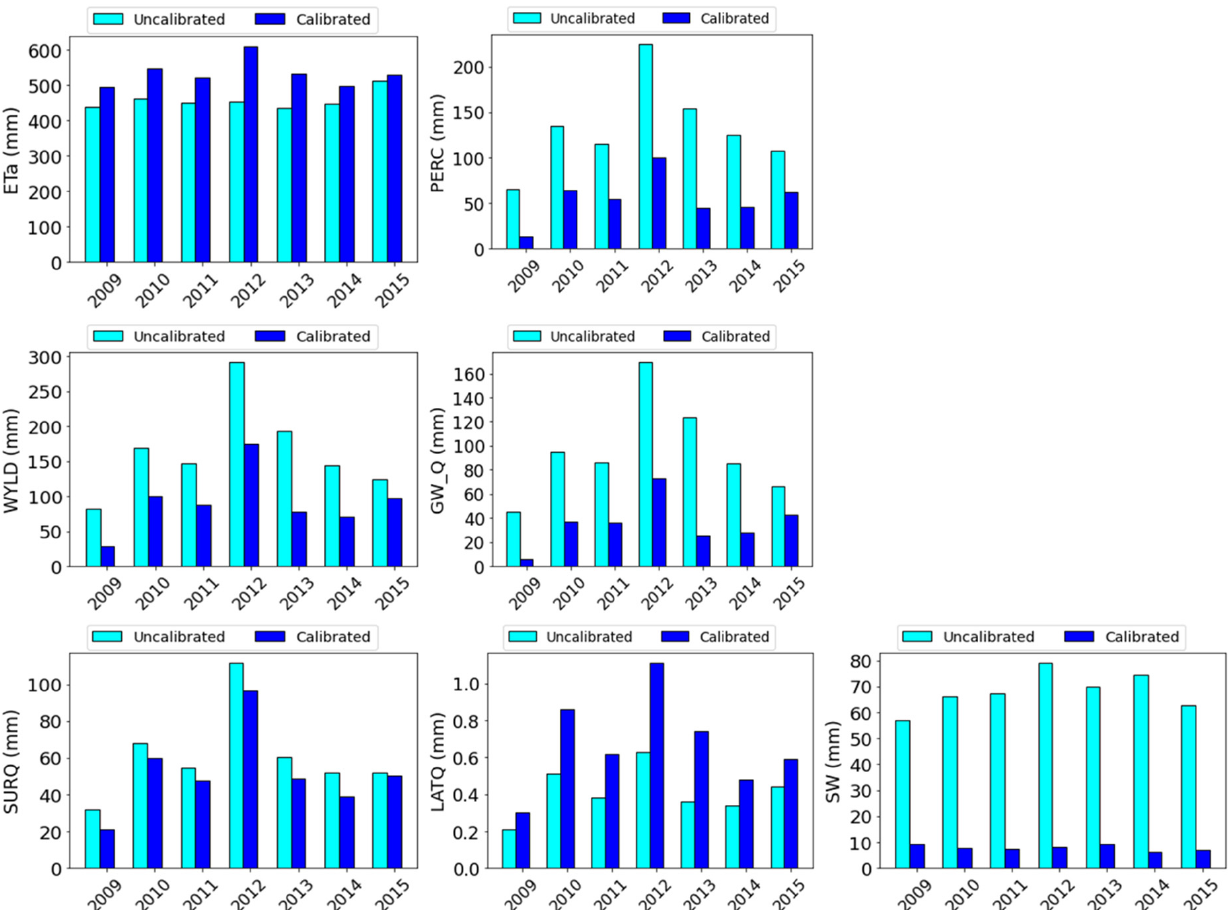
Figure 10. Average annual water balance components in the study area in the Lake Chad Basin based on SWAT-simulated output before (Uncalibrated) and after (Calibrated) calibration. (ETa: actual evapotranspiration; SW: soil water content; PERC: perception; SURQ: surface runoff; GW_Q: groundwater recharge; WYLD: water yield; LATQ: lateral runoff.